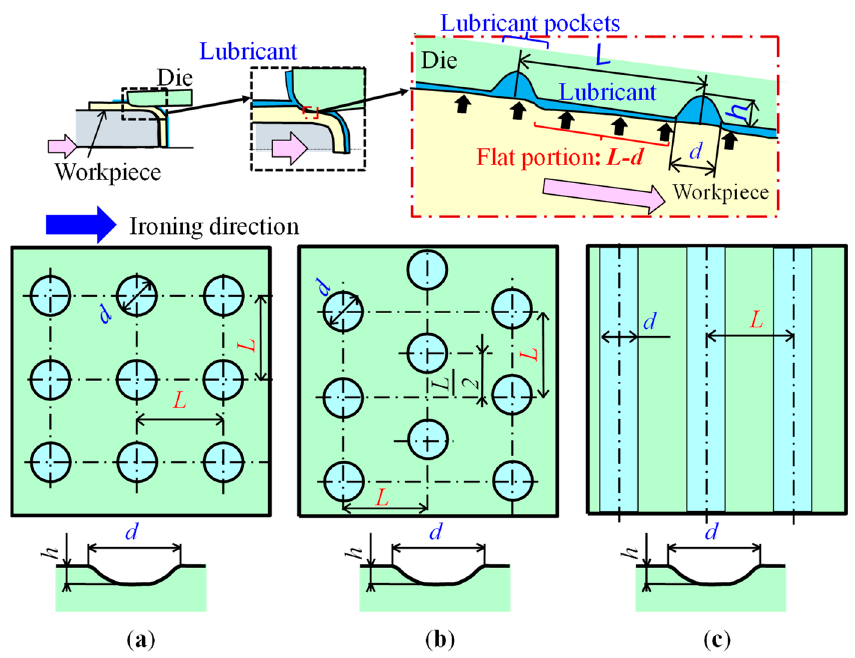
Figure 1. Schematic illustration of array patterns of micro-lubricant pockets: ( a ) grid, ( b ) crossing, and ( c ) grooved array patterns. Table 1. Geometrical parameters of array patterns of